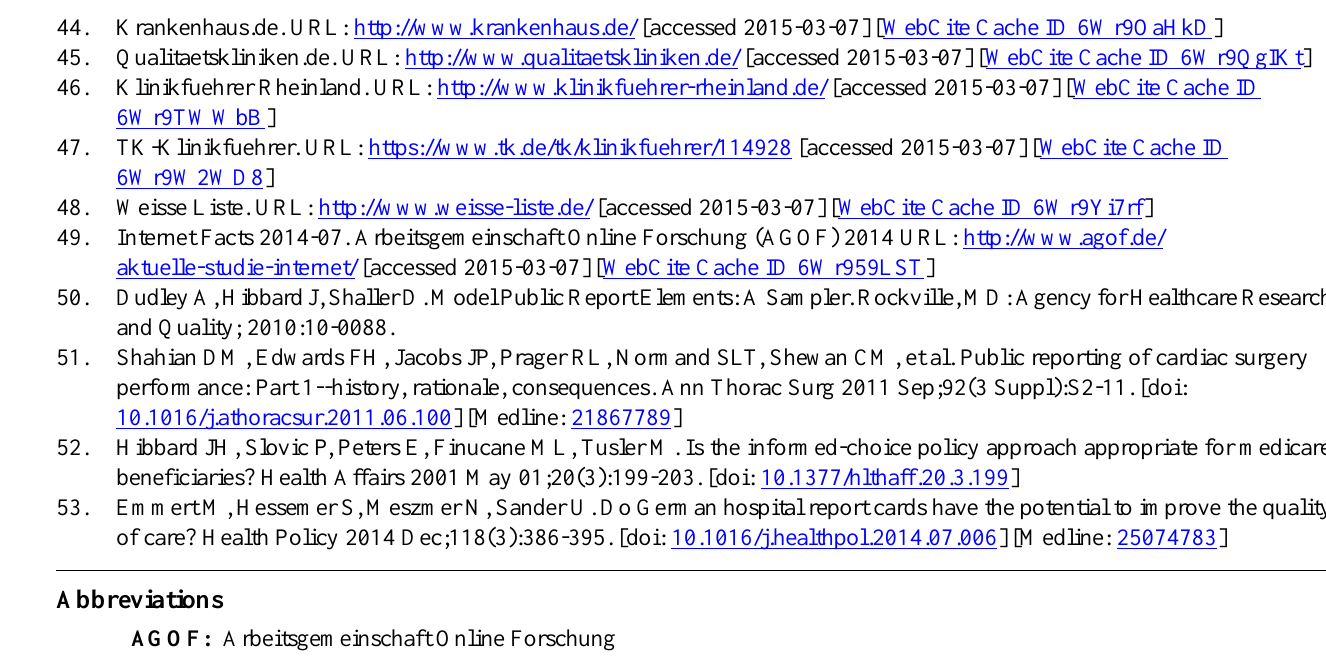
AGOF: Arbeitsgemeinschaft Online Forschung PCI: percutaneous coronary intervention RAMR: risk-adjusted mortality rate